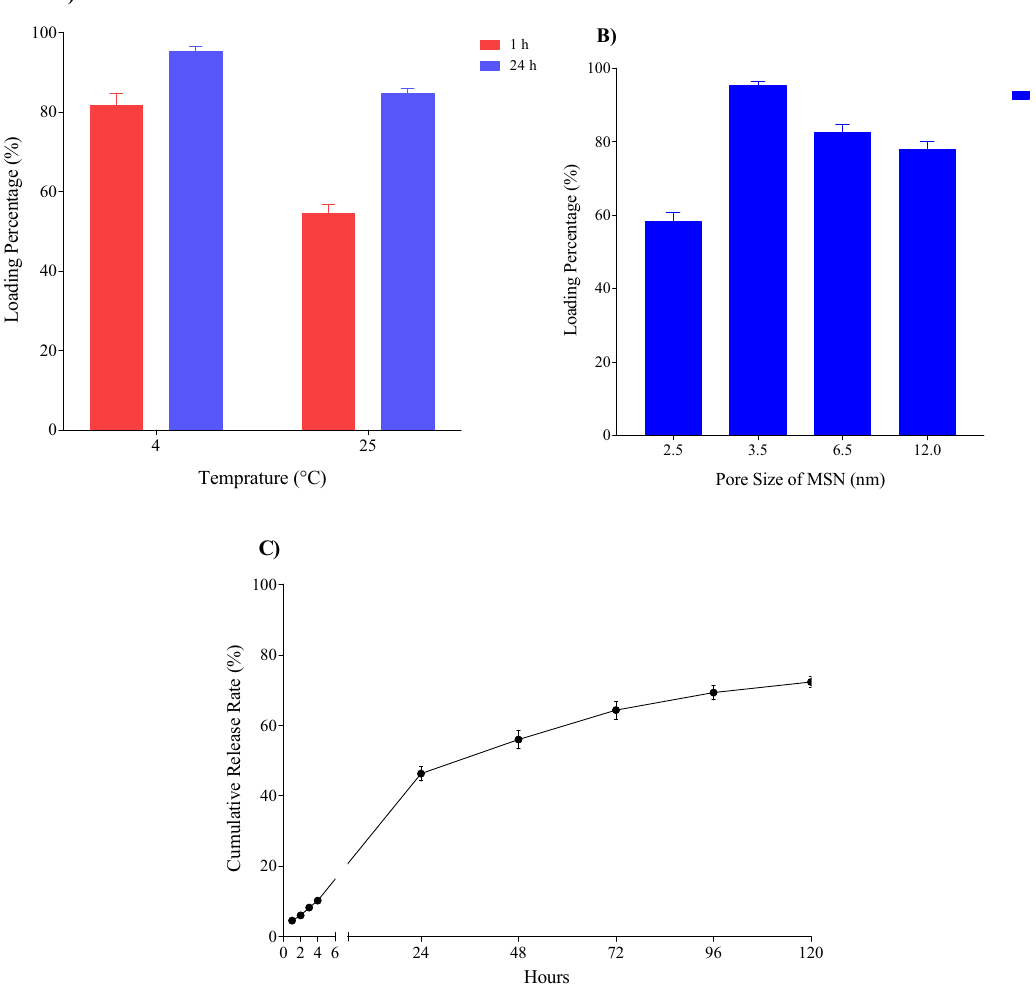
Figure 4. siRNA loading and releasing profile. ( A ) Loading profile of siRNA on [FA-PEGylated/PEI@GuIL@ KIT-6] nanocarrier in 1 and 24 h incubation time at 4 and 25 °C. The best loading results of final complex achieved to 96% of loading in 24 h of incubation at 4 °C, with ratio of 1:35 of siRNA to [FA-PEGylated/PEI@ GuIL@KIT-6] equivalent to 2.1 µM siRNA in combination with 48.3 µg of